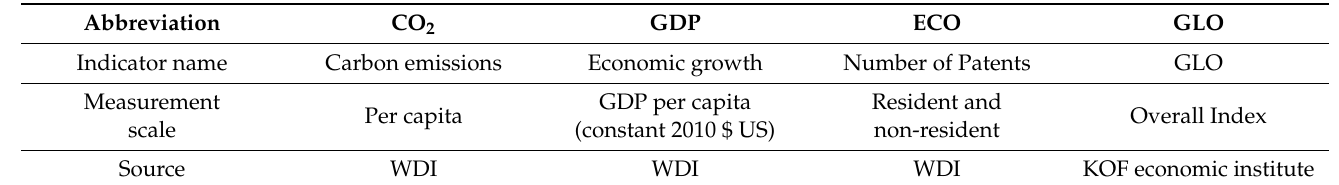
Table 1. Variables and their